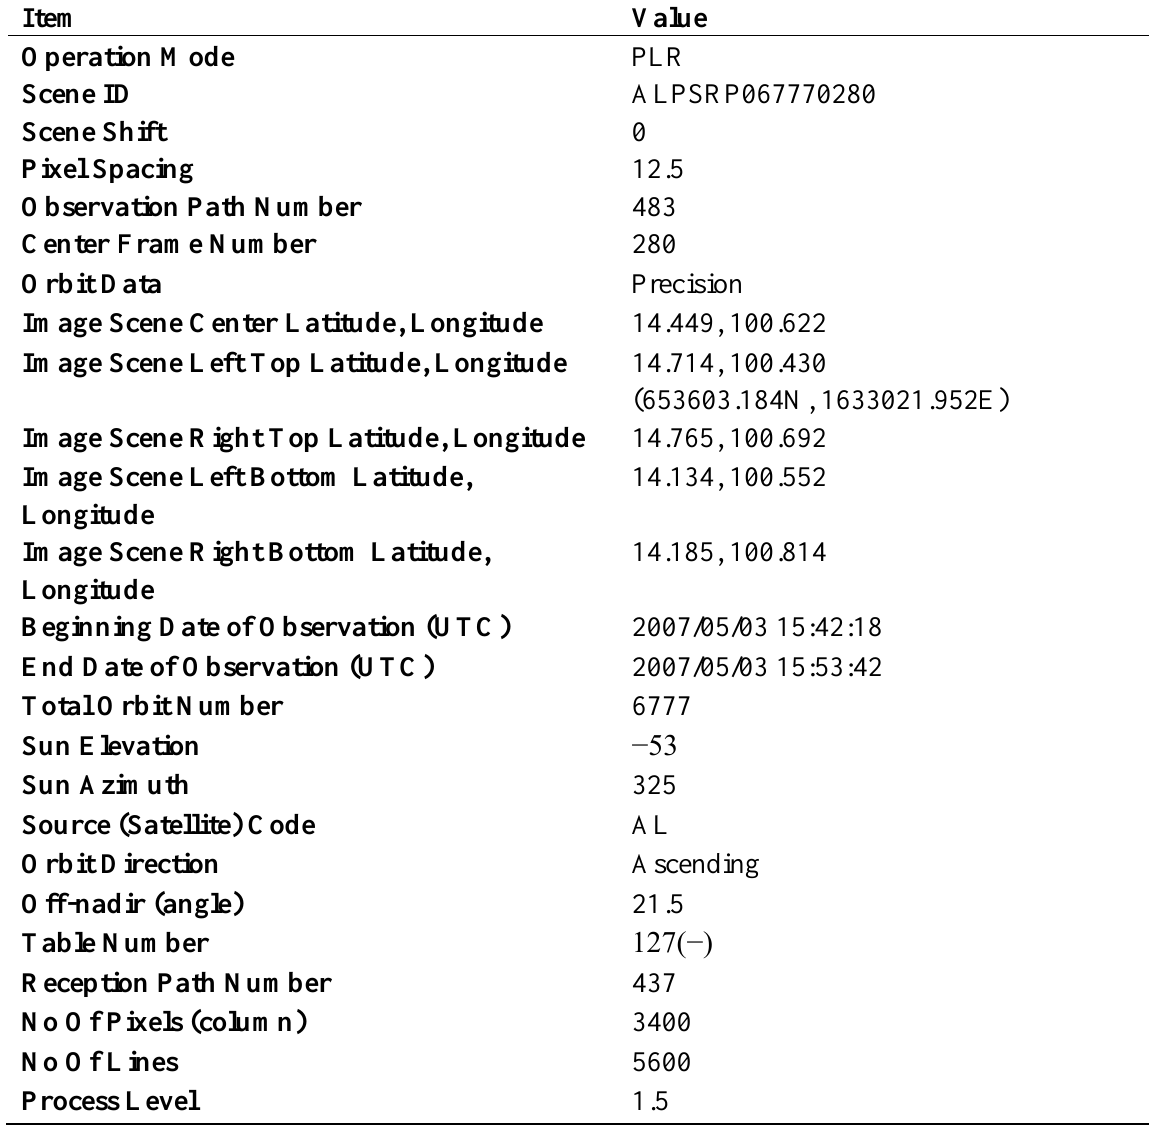
Table A2. Detailed information of the PALSAR sensor (Scene ID: